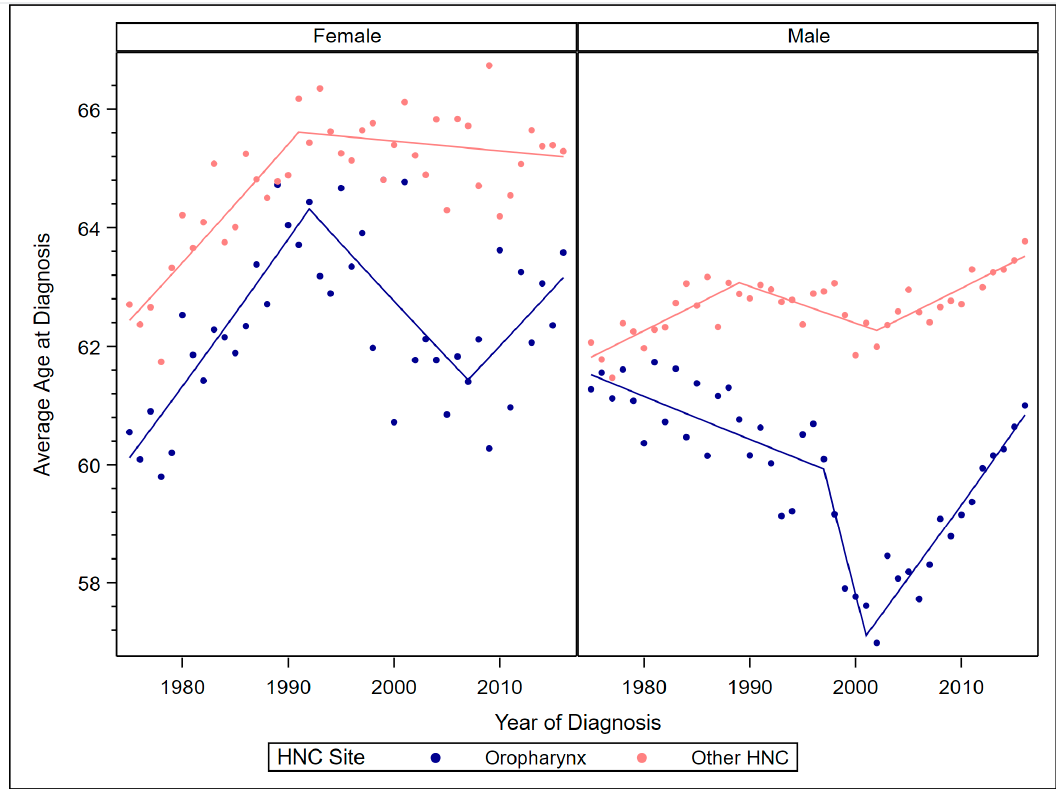
Figure 2. Observed average age at diagnosis by year and Joinpoint models by sex and site.